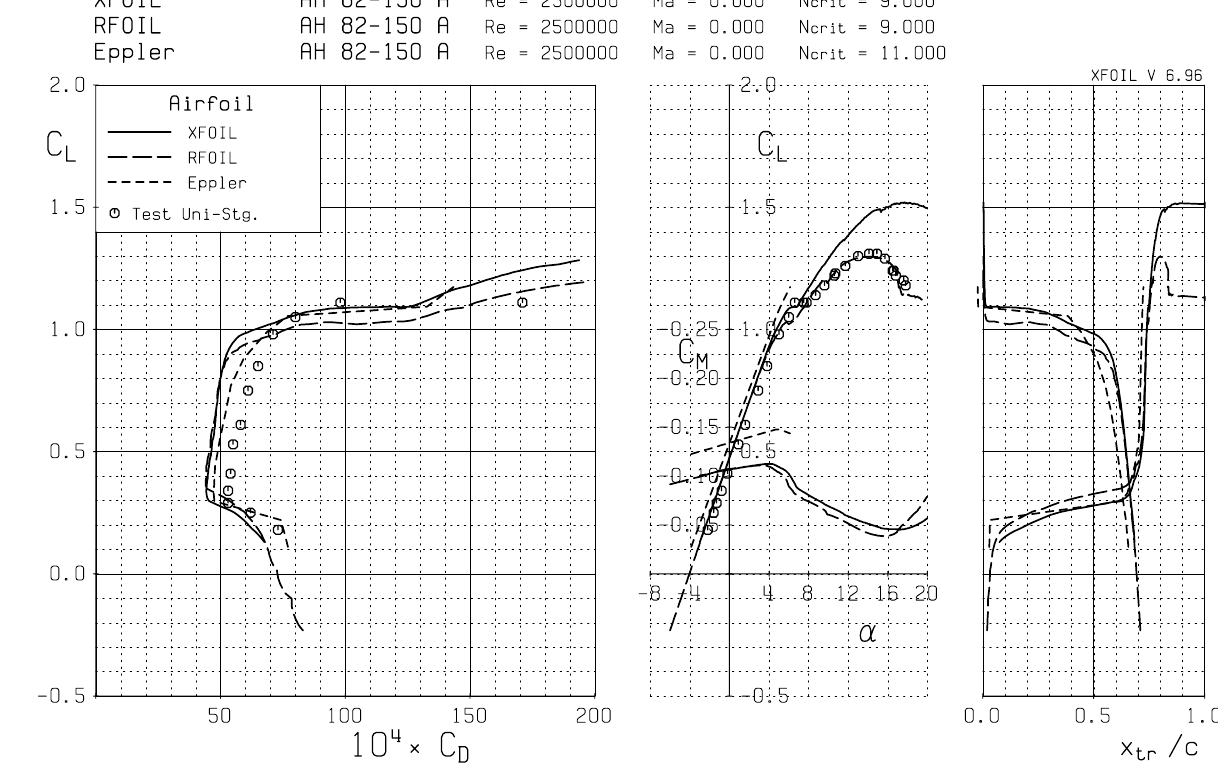
Fig 12. Comparison of calculated and measured data of AH82-150A airfoil at Re = 2.5·10